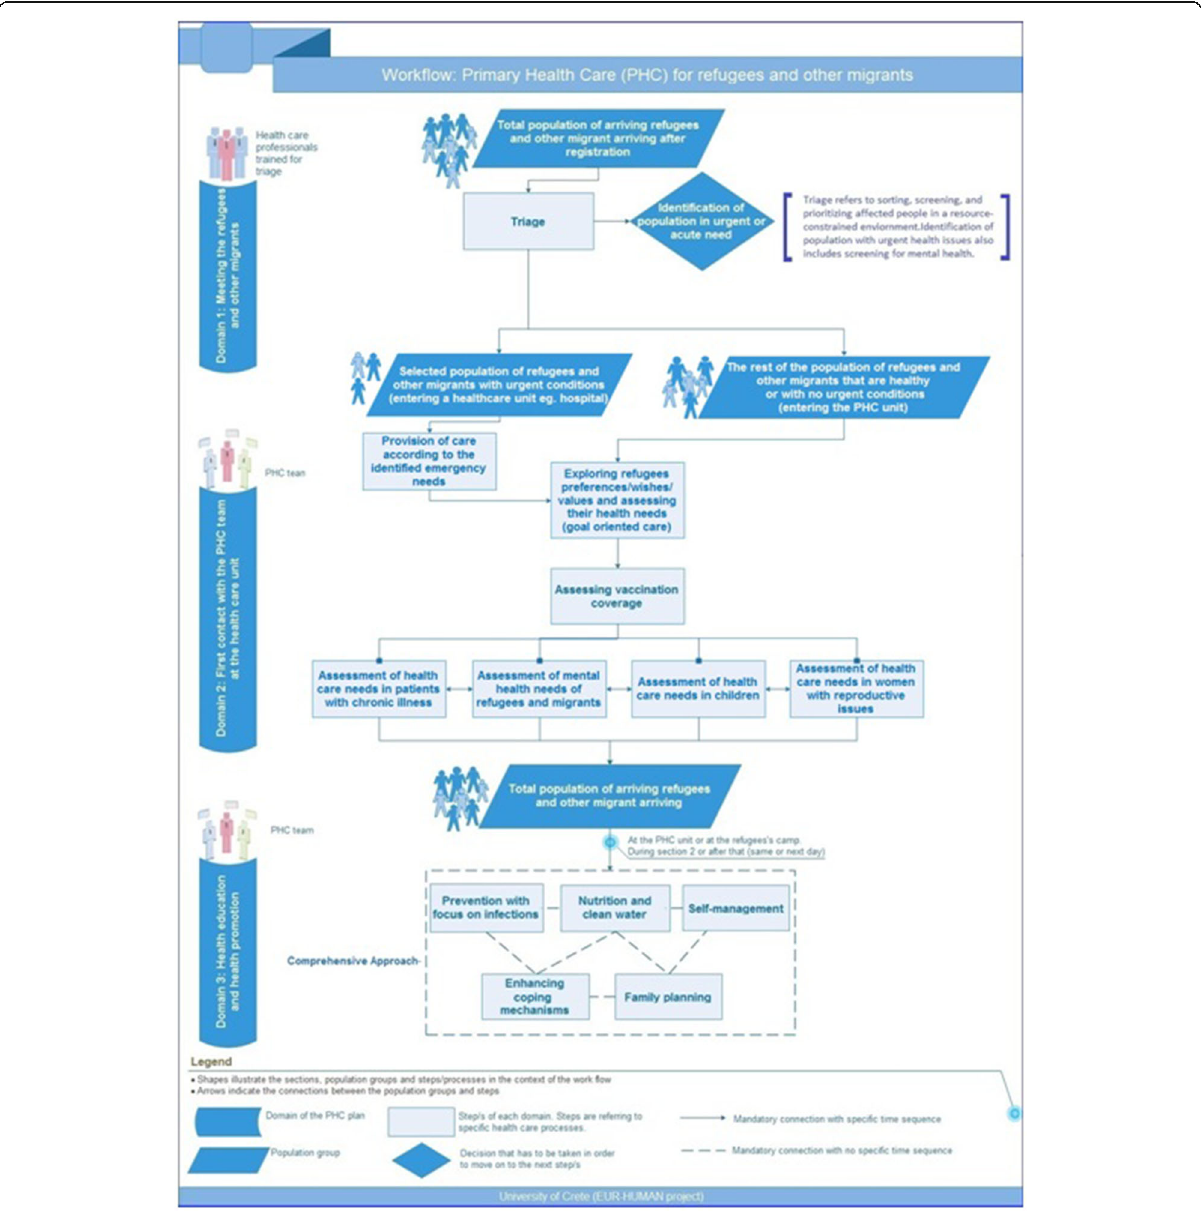
Fig. 2 Workflow of Primary Health Care services for refugees and other migrants (Source: http://eurhuman.uoc.gr/wp-content/uploads/2017/06/